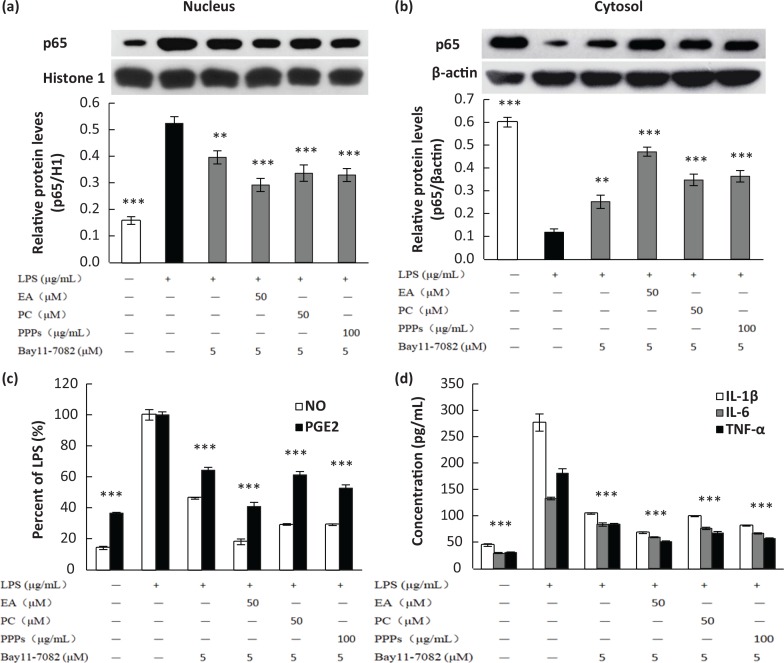
The effect of test polyphenols on LPS-induced NF-κB p65 translocation (a, b), the production of NO/PGE2 (c), and pro-inflammatory cytokines (d) in RAW264.7 macrophages. Cells were pretreated with different concentrations of PPPs, PC, EA, or Bay11-7082 (5 μM) for 1 h and then stimulated with LPS (1 μg/mL) for 20 min. The total lysates of the proteins were subjected to Western blot analysis, and the culture media were collected for NO and ELISA detections. Data are expressed as mean ± SD. **P < 0.01 and ***P < 0.001 compared with LPS-stimulated group.